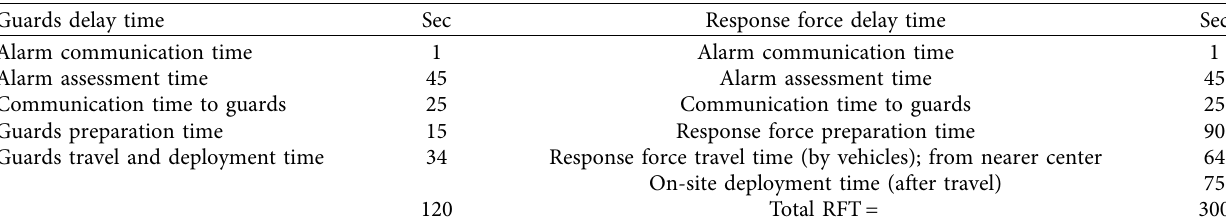
Table 2: The response force travel time after relocation of response force center for scenario